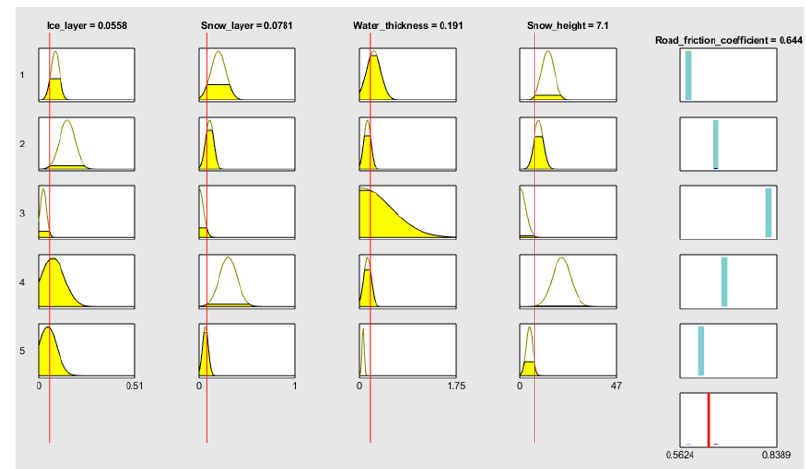
Figure 5. View of the fuzzy rule base for the designed intelligent fuzzy system for RSFC prediction (trained if-then rules).